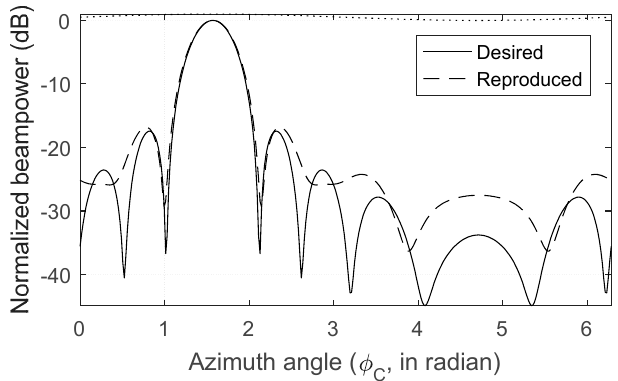
Figure 4. Normalized beam-power distributions of the desired and the reproduced fields with ρ = 0.9.